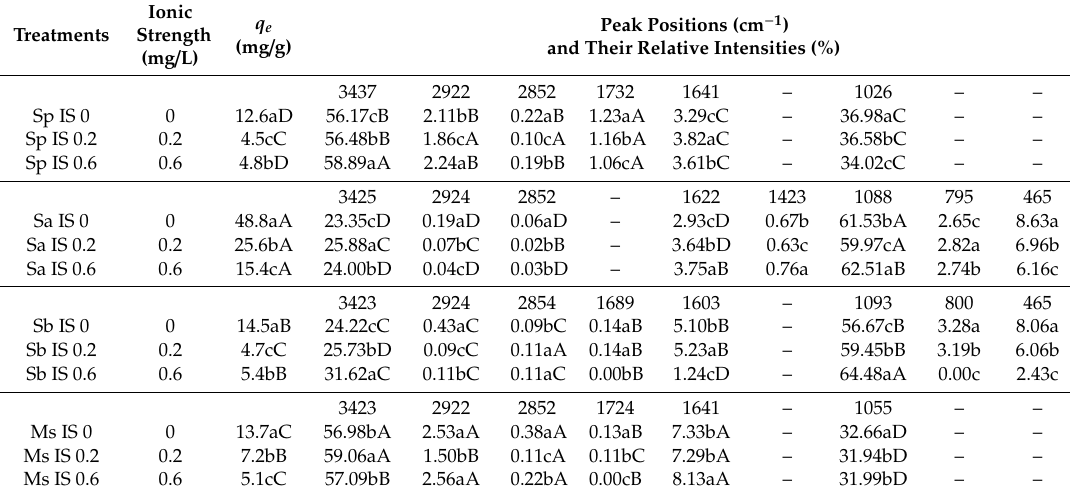
Table 4. Adsorption Capacity of Cd(II) on the Four Adsorbents from Rice Straw under Di ff erent Ionic Strengths and the Relative Intensities of the Absorption